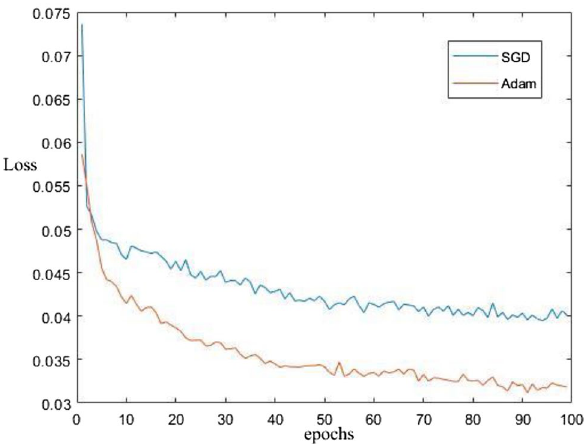
Figure 12. The training results of the SGD optimization algorithm and Adam optimization algorithm for the loss value in the YOLOv5 network model.